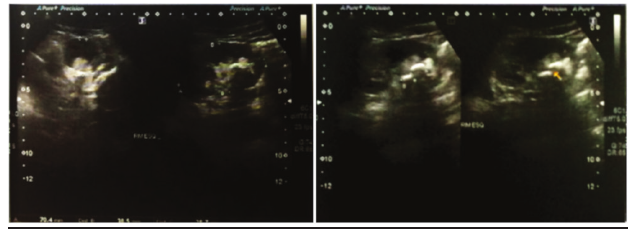
figurE 2 − Dynamic US of left kidney showing kidney size and staghorn calculus (yellow arrow) size US: